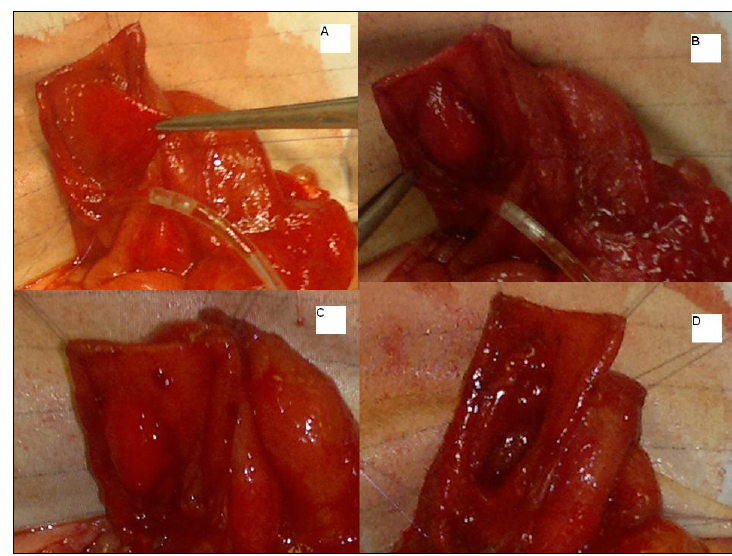
Figure 2: Intra-operative findings and